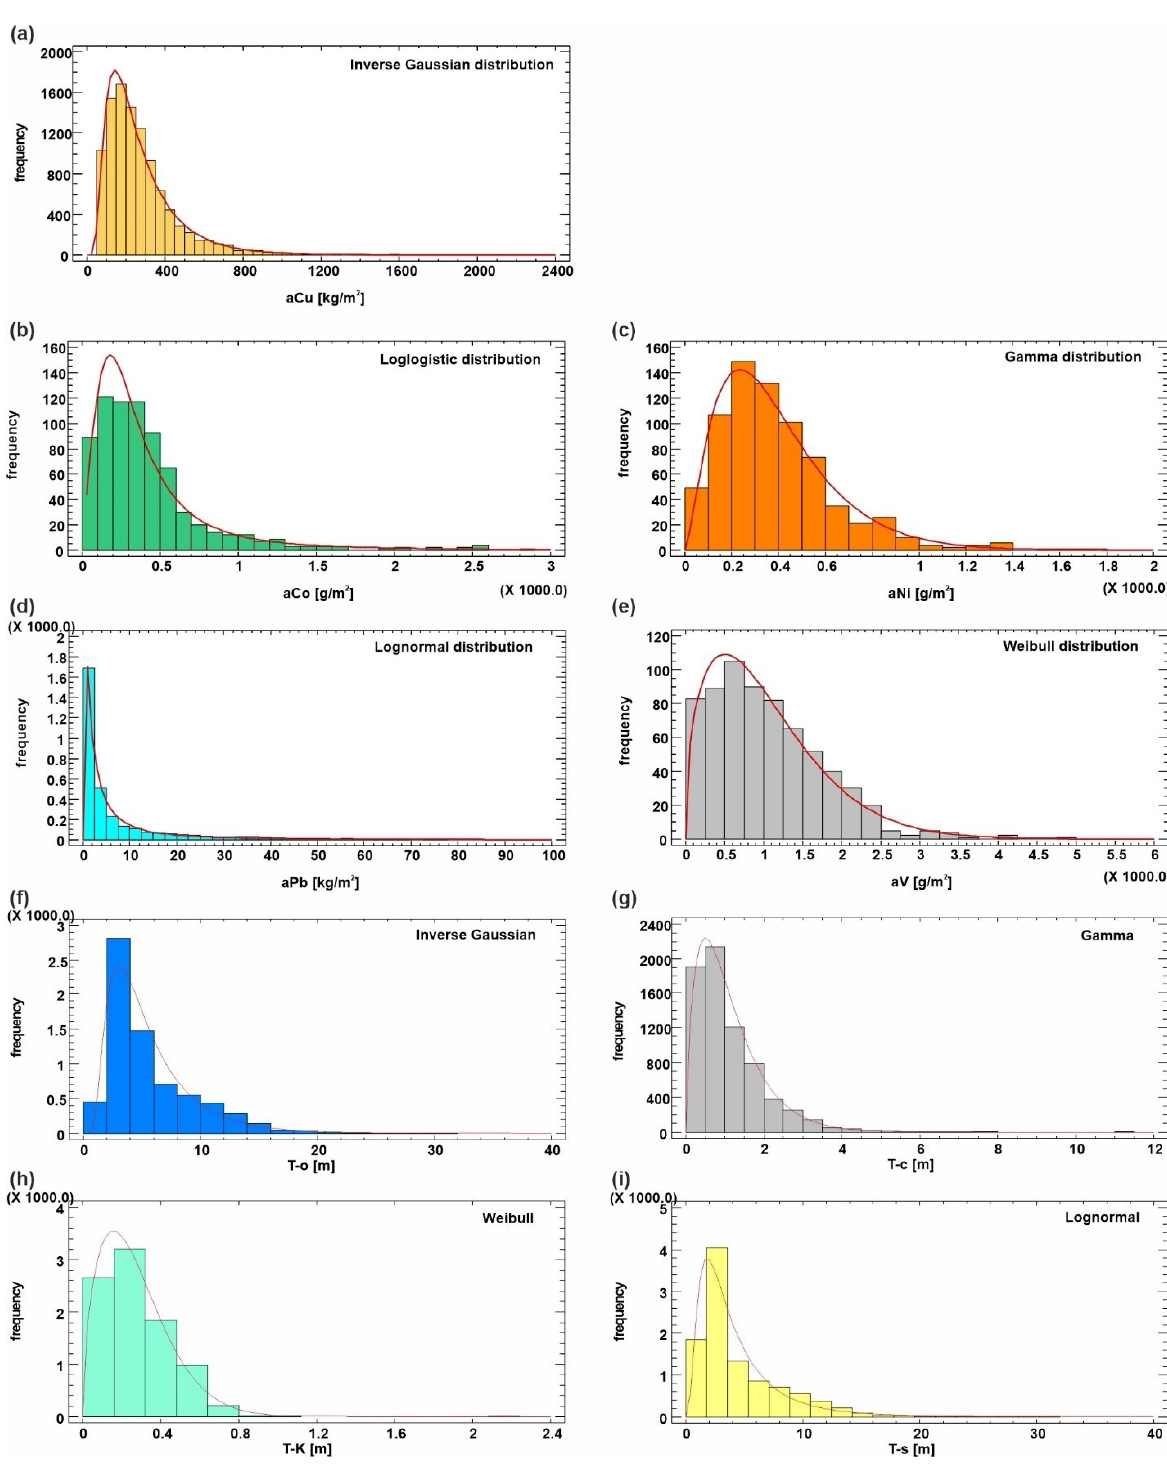
Figure 5. Histograms and optimal theoretical distributions of metal abundance (aCu, aCo, aNi, aPb, and aV ( a – e )) and thickness for fitted to empirical distributions according to the log-likelihood statistic (Explanations: ( f ): (T-o)—thickness of ore deposit, ( g ): (T-c)—the carbonate ore, ( h ): (T-K)—the Kupferschiefer ore, ( i ): (T-s)—sandstone ore); K-S Test—Kolmogorov-Smirnov test of the consistency of the empirical distribution with the assumed theoretical distribution, p -value ≤ 0.05—rejection of the hypothesis on the consistency of the empirical distribution with the assumed theoretical distribution for significance level 0.05, p -value > 0.05—there are no grounds to reject the hypothesis that the empirical distribution is compatible with the assumed theoretical distribution.